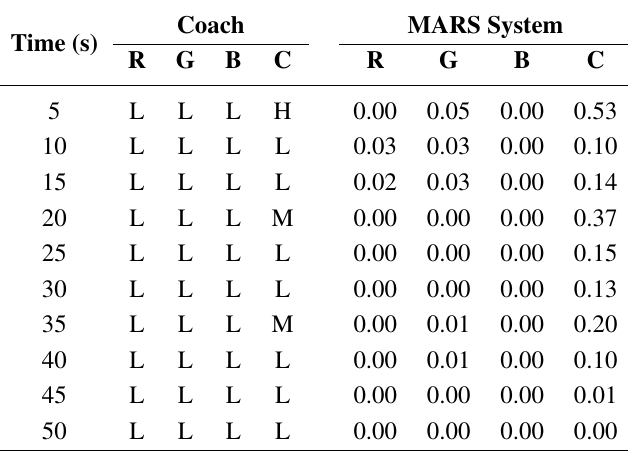
Table 6. Session D , coach and system